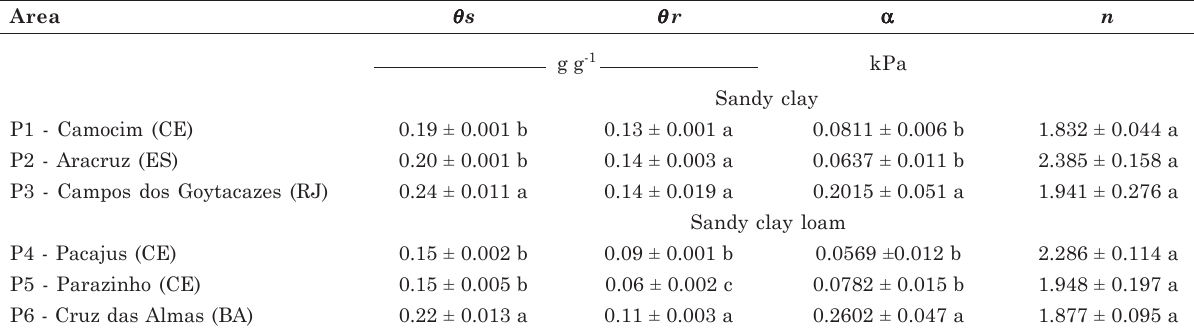
Means followed by the same letter in the columns do not differ significantly